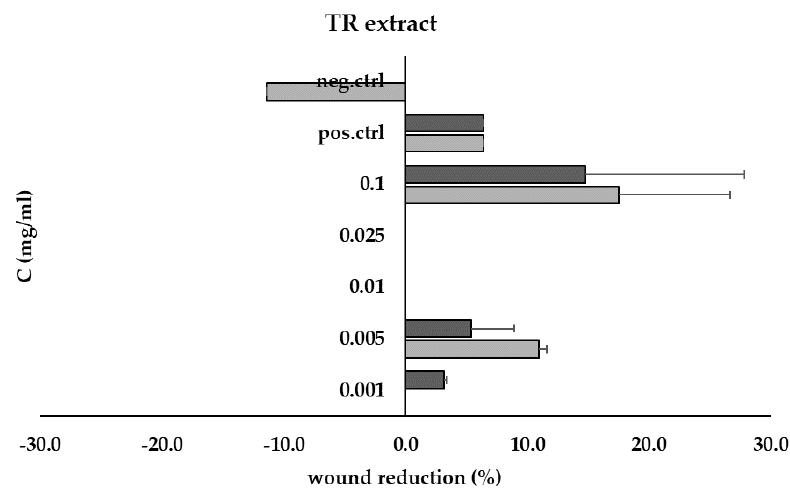
Figure 7. Wound recovery (% scratch reduction) at 24 h ( ■ ) and 48 h ( ■ ) for TR root extract at concentrations ranging from 0.001 mg/mL to 0.1 mg/mL, compared to positive (pos.ctrl) and nega- tive (neg.ctrl)